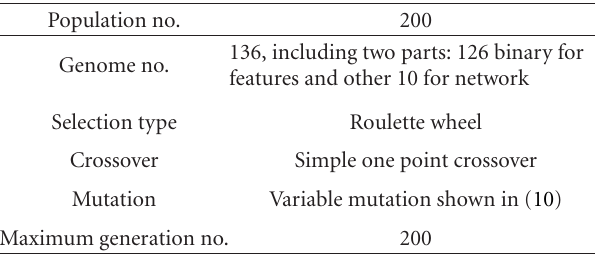
Table 4: Binary genetic algorithm parameters setting for feature se-